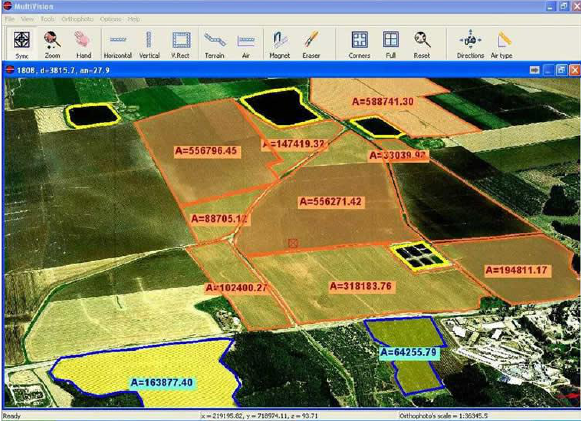
Figure 6. Parcel area measurements (Aeromap, 2006) Realistic 3D city models obtained by texturing oblique data